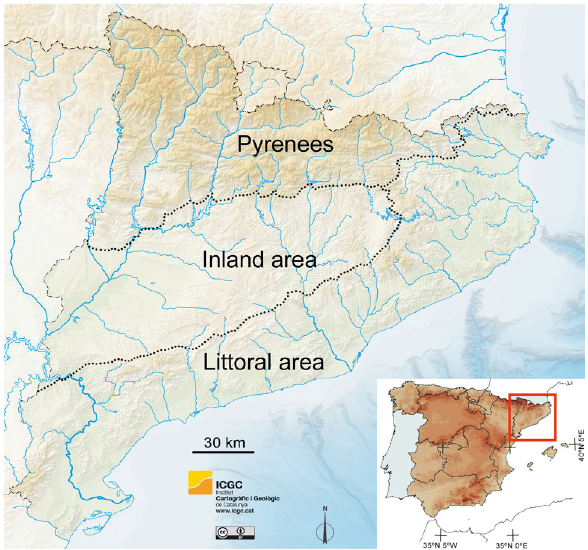
Figure 1. Map of the studied area divided in its three main geographical